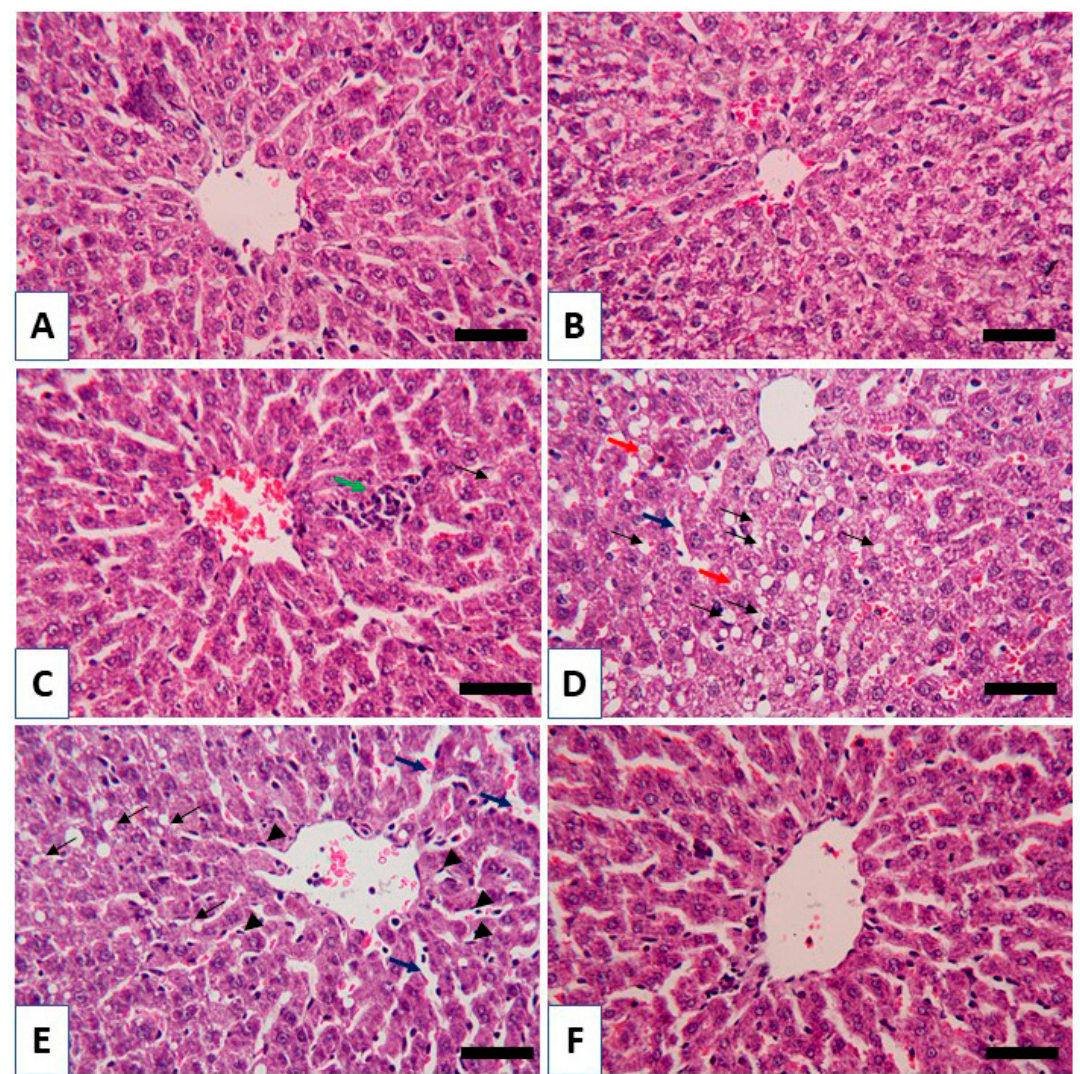
Figure 4. RBR inhibits histological alterations in CPF-intoxicated rats. Photomicrographs of sections in liver of ( A ) control, ( B ) RBR-supplemented groups showing normal hepatic lobules and hepatocytes, ( C – E ) CPF-intoxicated rats showing leukocyte infiltration (green arrow), vacuolations (black arrow), cytoplasmic vacuolations with eosinophilic substance (red arrow), dilated sinusoids (blue arrow) and Kupffer cells (arrow head) and ( F ) CPF-intoxicated rats treated with RBR showing no histological alterations. (X400, Scale bar 50 μ m.).